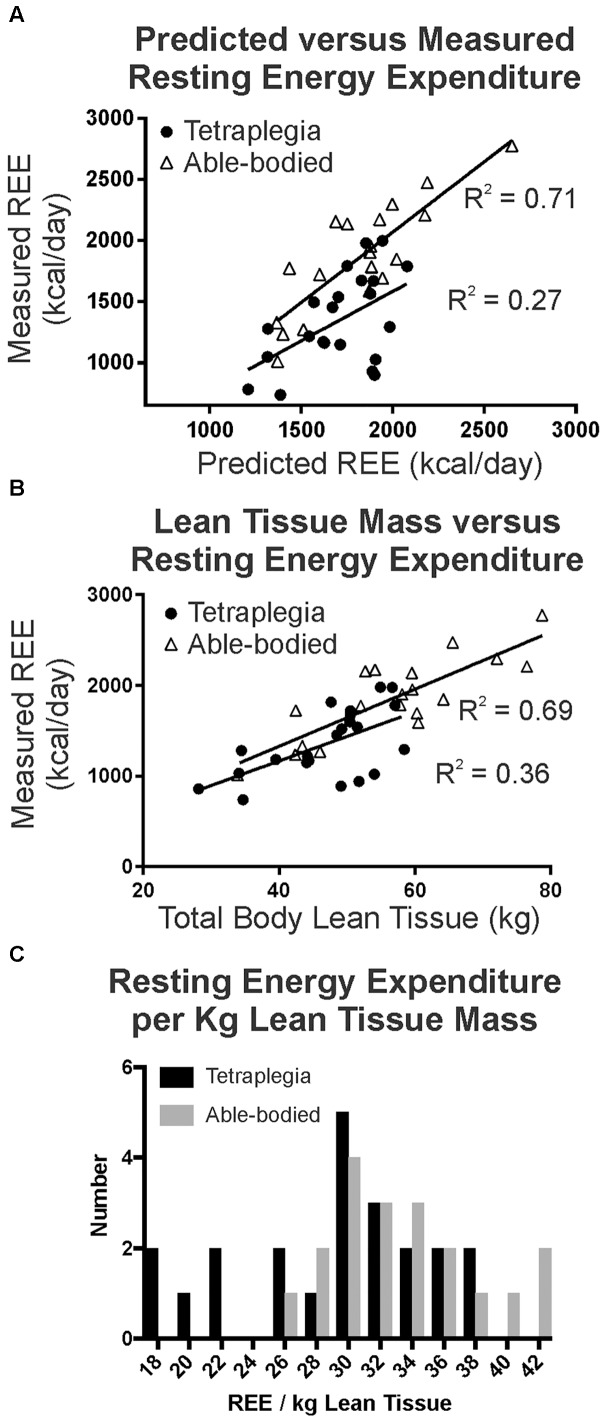
(A) A strong correlation between predicted and measured resting energy use is seen in age-height-sex matched controls (R2 = 0.71), whereas a much weaker correlation existed in participants with tetraplegia (R2 = 0.27, Pearson, p < 0.05). (B) Total lean tissue mass better predicted measured REE in able-bodied controls than in participants with tetraplegia. (C) Histogram demonstrates a subgroup with tetraplegia had very low REE per kg of lean tissue.